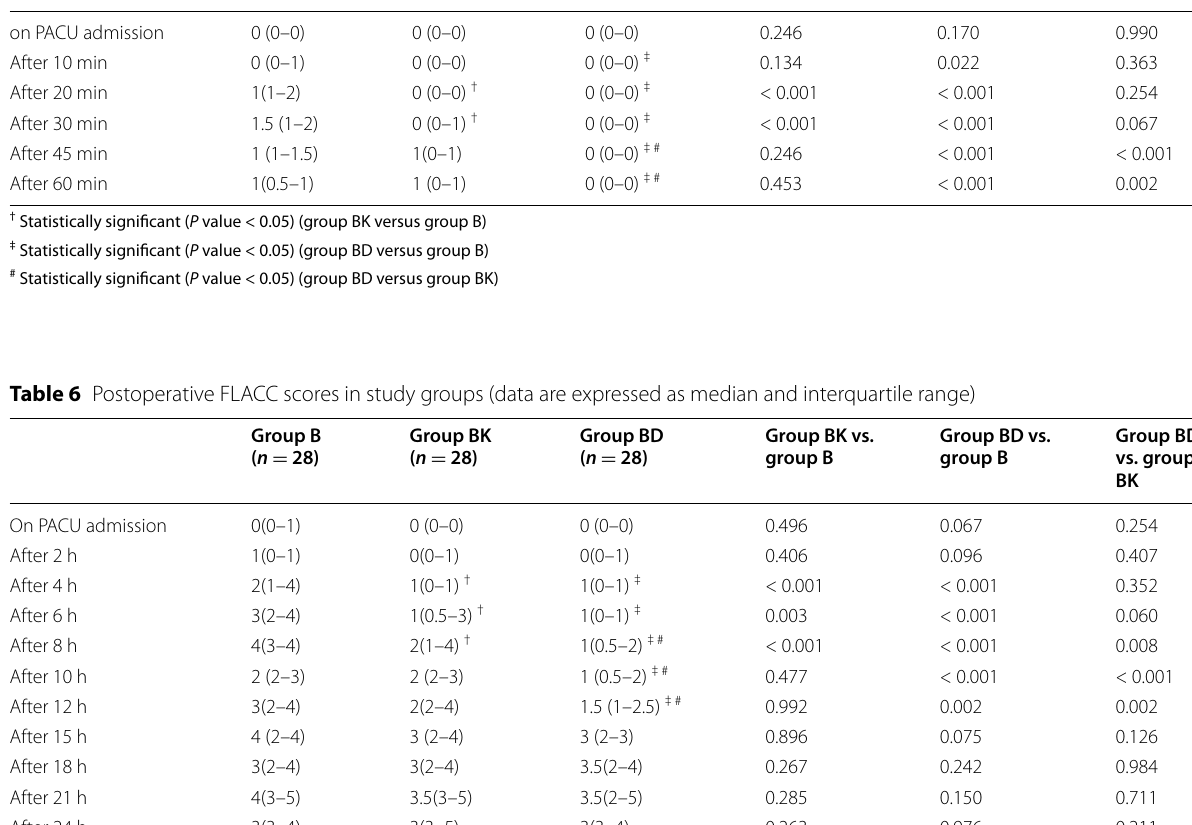
† Statistically significant ( P value < 0.05) (group BK versus group B) ‡ Statistically significant ( P value < 0.05) (group BD versus group B) # Statistically significant ( P value < 0.05) (group BD versus group